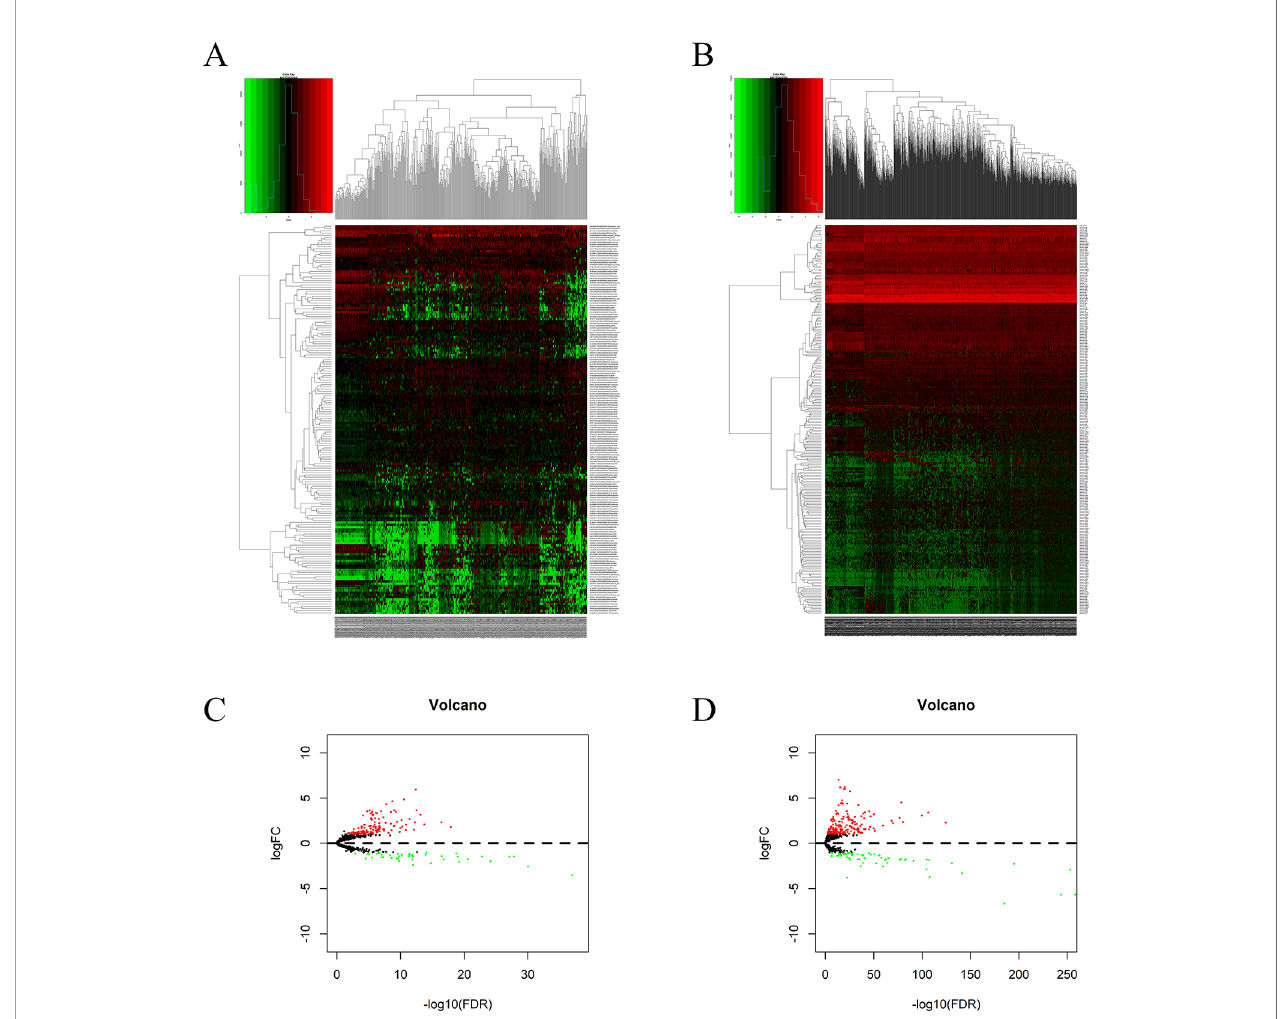
FIGURE 6 | DElncRNAs and DEmiRNAs in patients with HCC: Heatmap (A) and volcano plot (B) of DElncRNAs in HCC and adjacent non-cancer liver tissues. Heatmap (C) and volcano plot (D) of DEmiRNAs in HCC and adjacent non-cancer liver